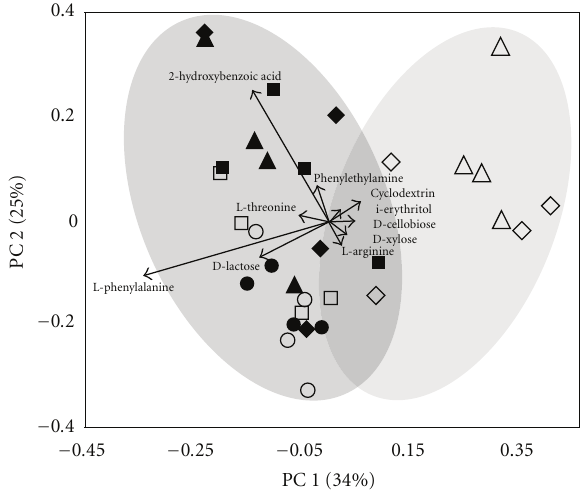
Figure 1: Ordination biplots of principal components (PC1 and PC2) from CLPP analysis of organic farm and pasture soils sub- jected to varying fertility regimes and crop rotations from August and September. Symbol designations are as described in Table 1